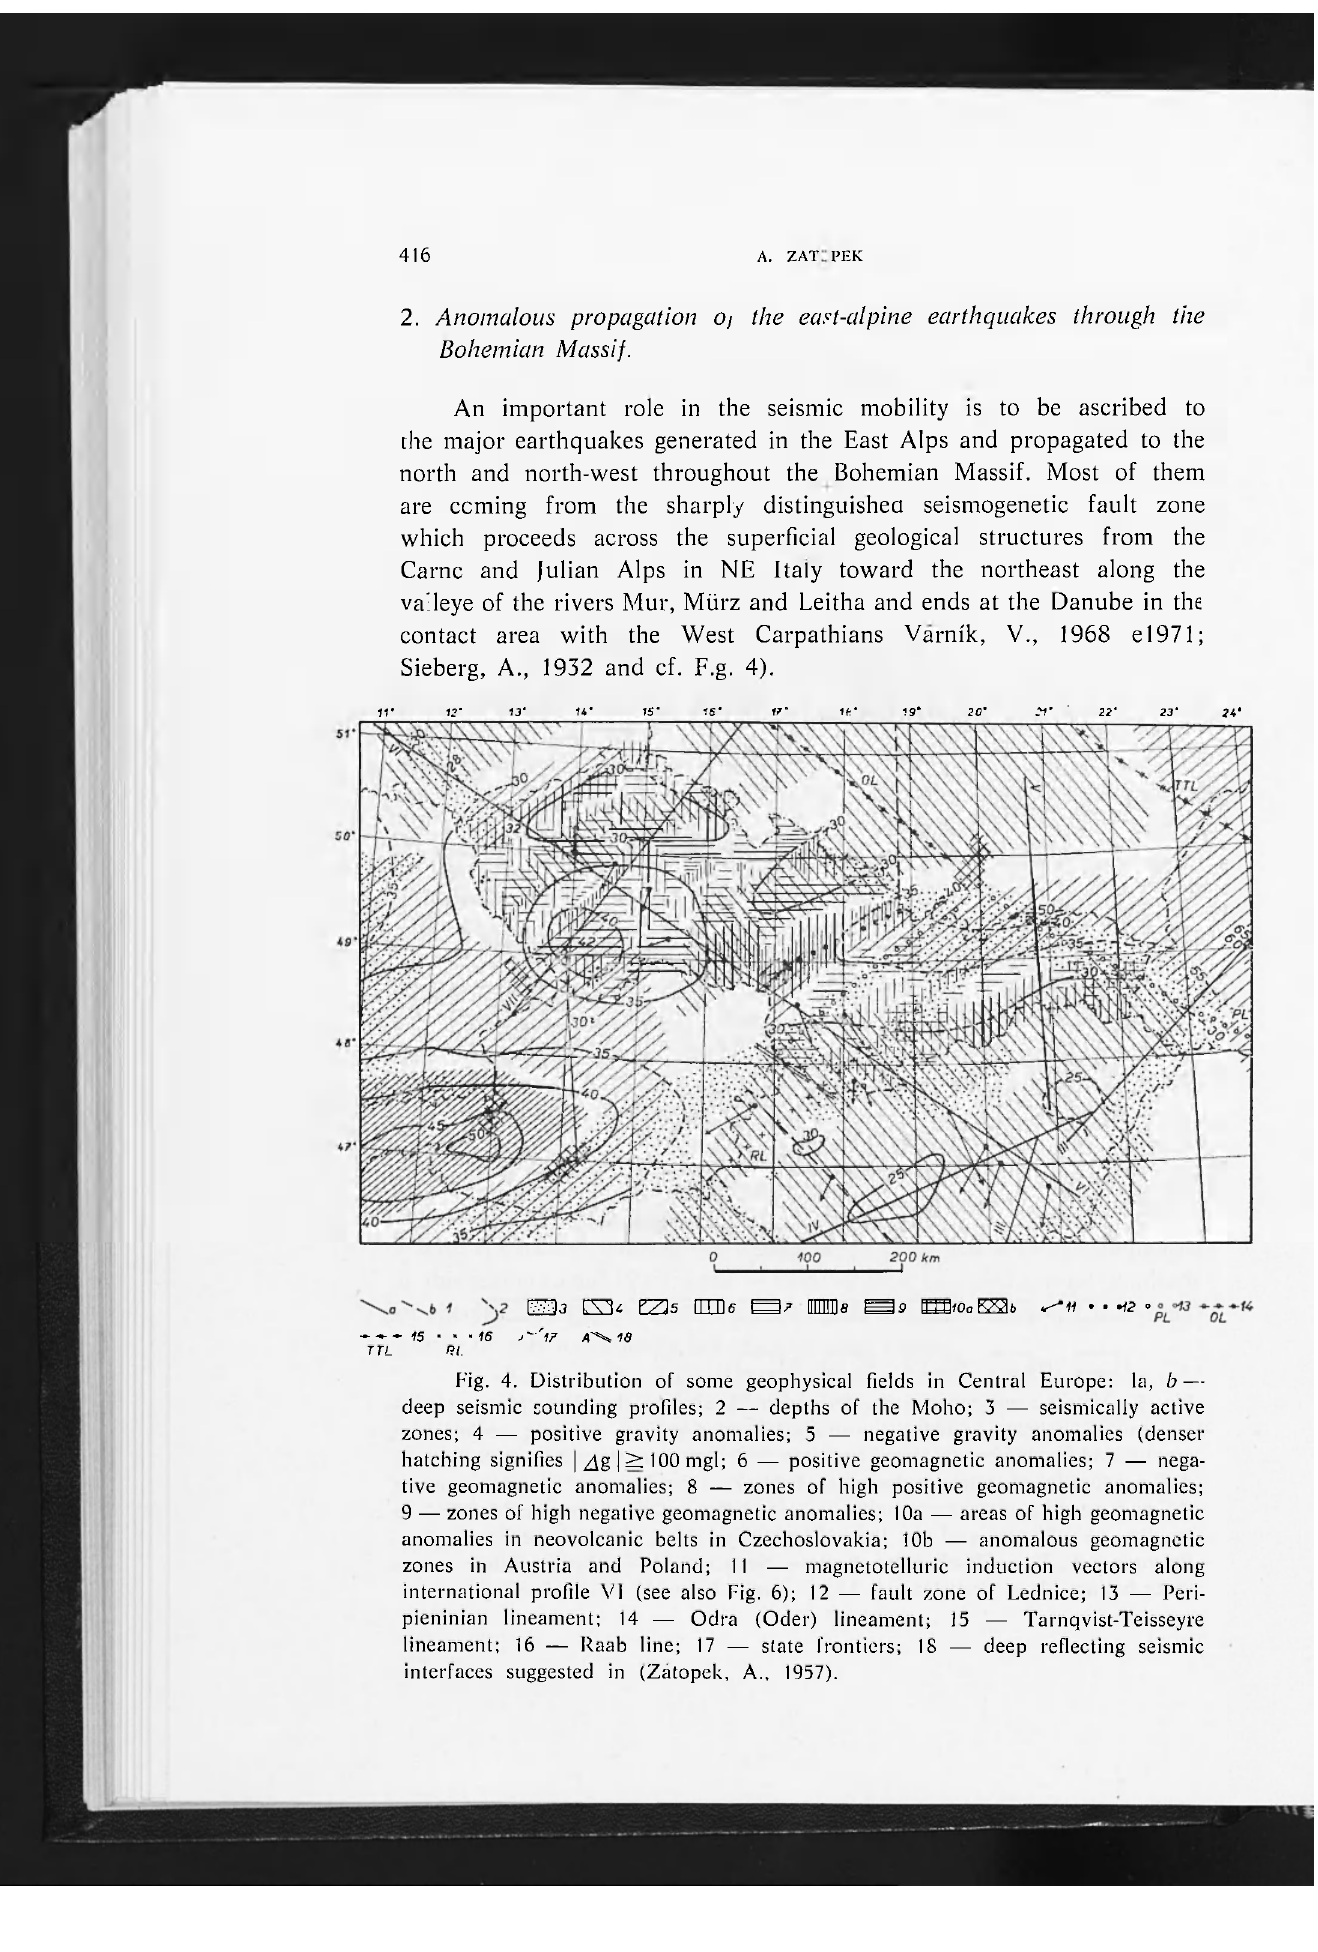
Fig. 4. Distribution of some geophysical fields in Central Europe: la, b — deep seismic sounding profiles; 2 — depths of the Moho; 3 — seismically active zones; 4 — positive gravity anomalies; 5 — negative gravity anomalies (denser hatching signifies | /\g | St 100 mgl; 6 — positive geomagnetic anomalies; 7 — nega- tive geomagnetic anomalies; 8 — zones of high positive geomagnetic anomalies; 9 — zones of high negative geomagnetic anomalies; 10a — areas of high geomagnetic anomalies in neovolcanic belts in Czechoslovakia; 10b — anomalous geomagnetic zones in Austria and Poland; 11 — magnetotelluric induction vectors along international profile VI (see also Fig. 6); 12 — fault zone of Lednice; 13 — Peri- pieninian lineament; 14 — Odra (Oder) lineament; 15 — Tarnqvist-Teisseyre lineament; 16 — Raab line; 17 — slate frontiers; 18 — deep reflecting seismic interfaces suggested in (Zatopek, A.,